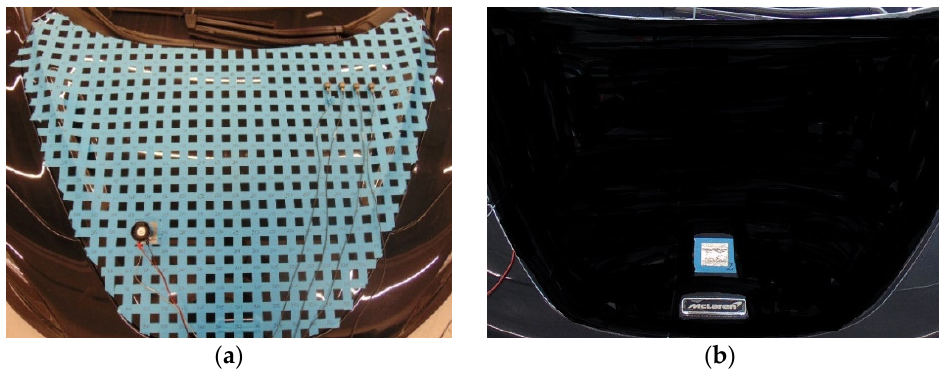
Figure 6. ( a ) Test vehicle bonnet subdivided into a grid of N = 368 measurement points. ( b ) Scheme of second measurement shaker’s position (low center) of the bonnet.